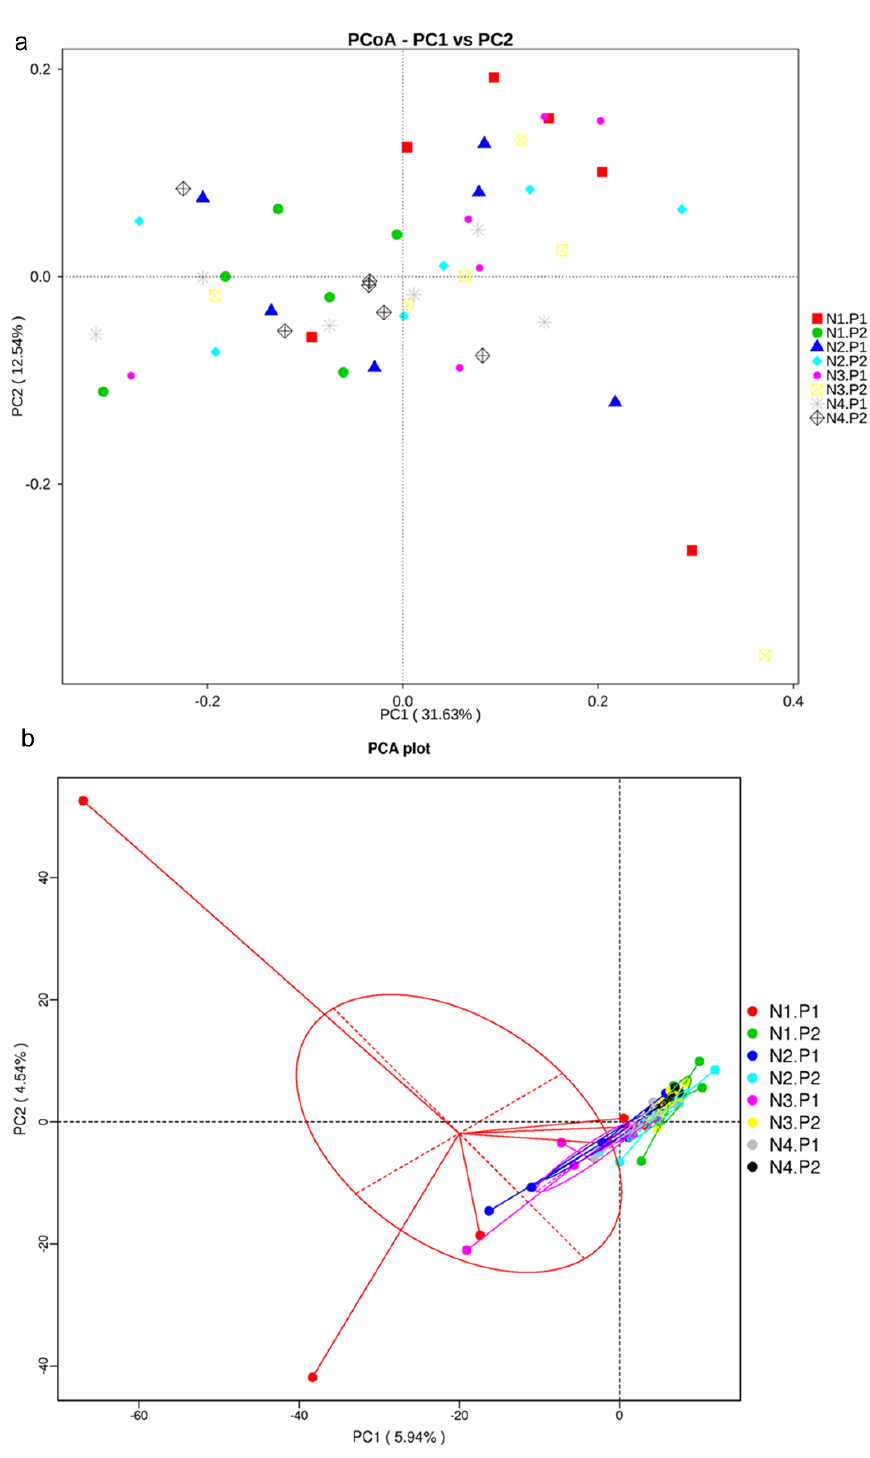
Figure 2. Principal co ‐ ordinates analysis (PCoA) and principal components analysis (PCA). ( a ), PCoA plot; ( b ), PCA plot. P1: The experimental period is 7 days. P2: The experimental period is 14 days. N1: 22.5 mg/kg niacin group. N2: 30 mg/kg niacin group. N3: 45 mg/kg niacin group. N4: 75 mg/kg niacin group.